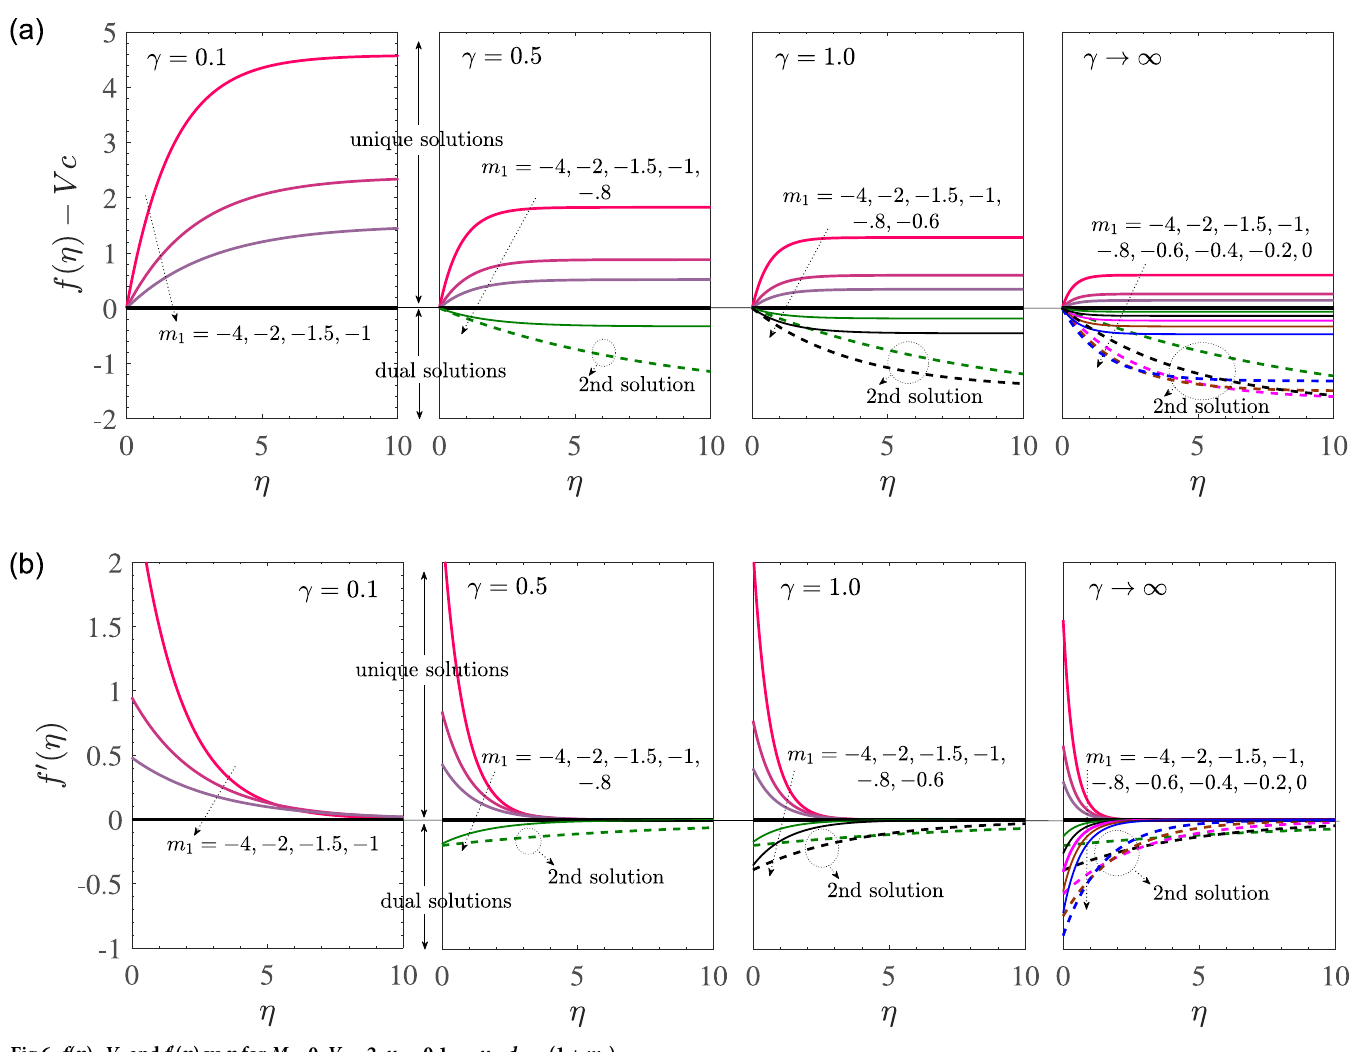
Fig 6. f ( η ) − V and f 0 ( η ) vs η for M = 0, V c